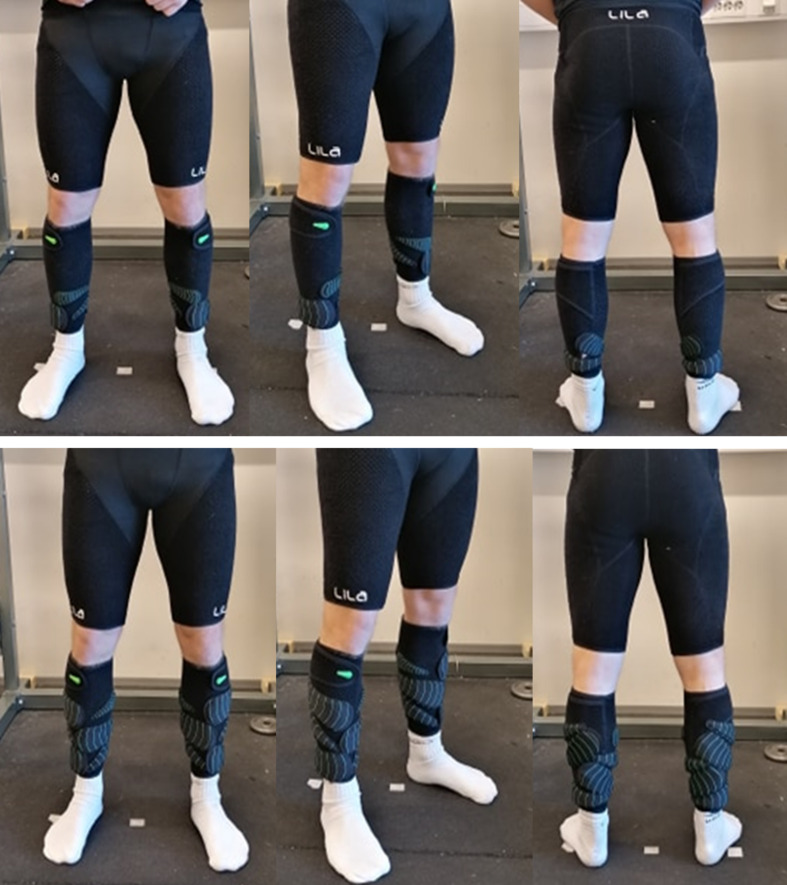
Illustration of 1 and 3% BM resistance with shank condition for a 70 kg football player.